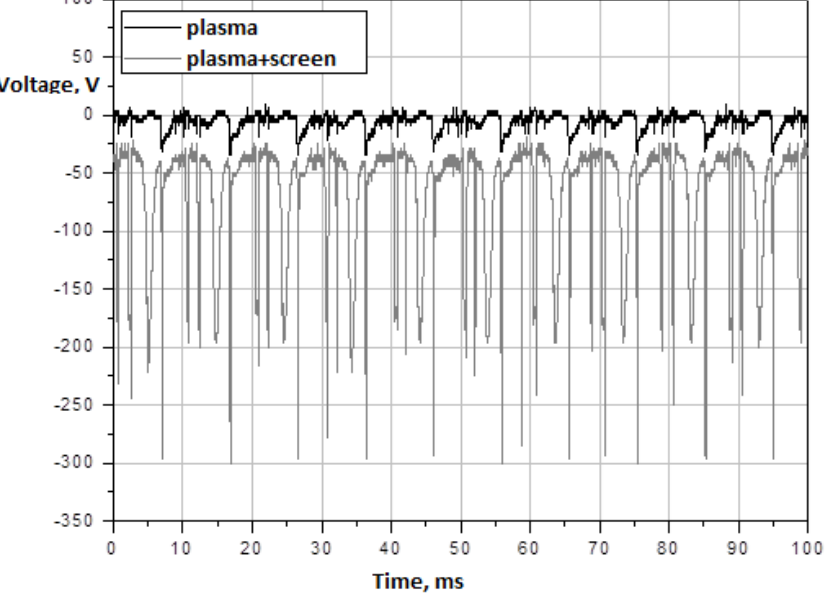
Figure 15. Comparison of voltage waveforms at the surface of the screened sample (bottom) and the unscreened control sample (top), which have no galvanic contact with the cathode. A time base of 10